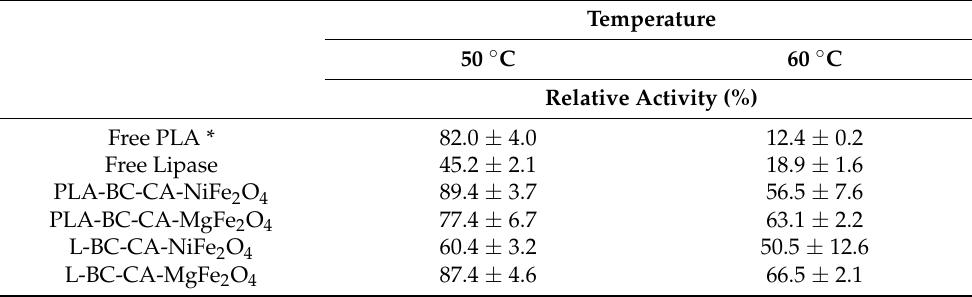
Table 2. Effect of temperature on the stability of free and immobilized